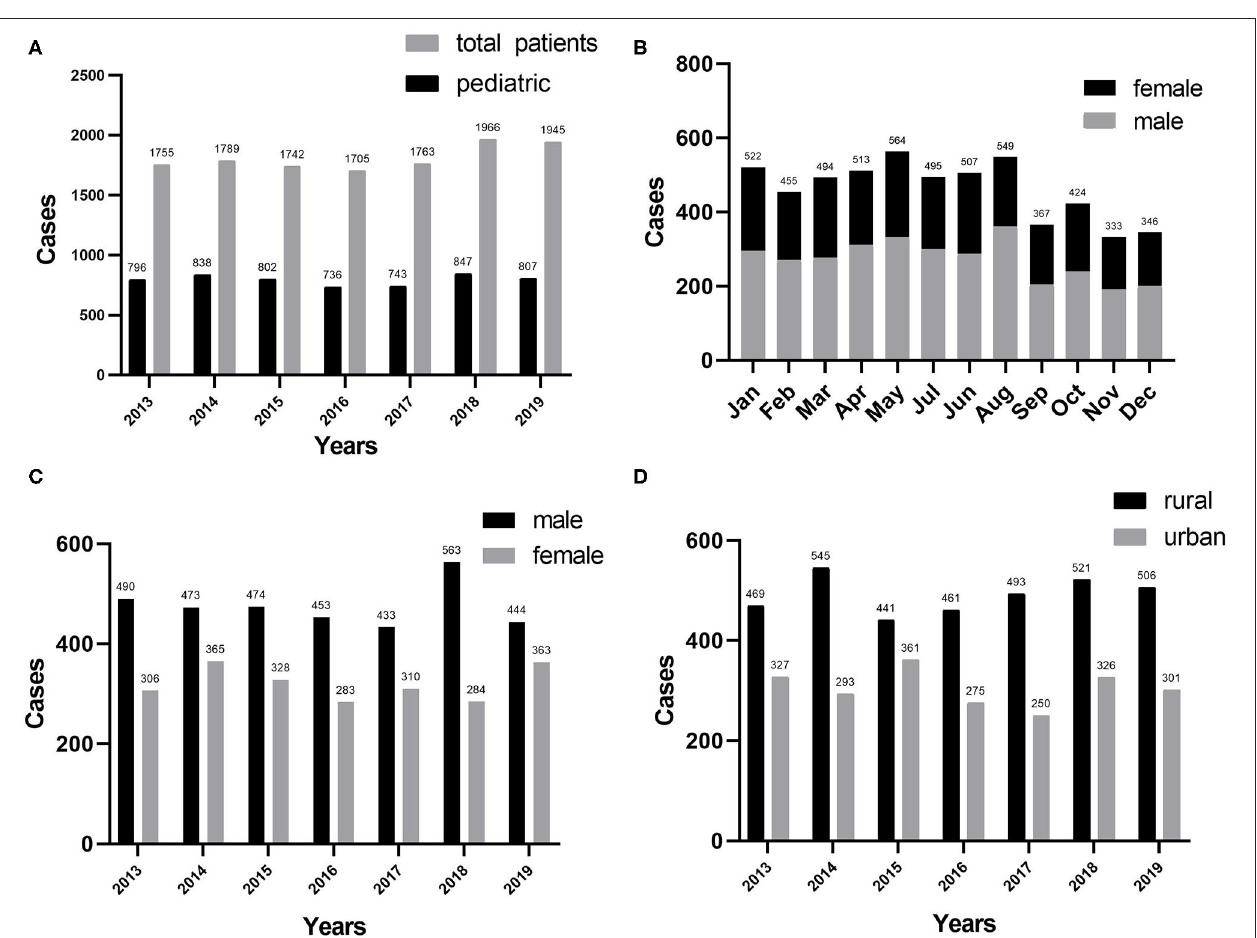
FIGURE 1 | (A) Distribution of pediatric burns ( n = 5,569) by years. (B) Pediatric burns by month. (C) Distribution of gender by years. (D) Regional distribution by years.